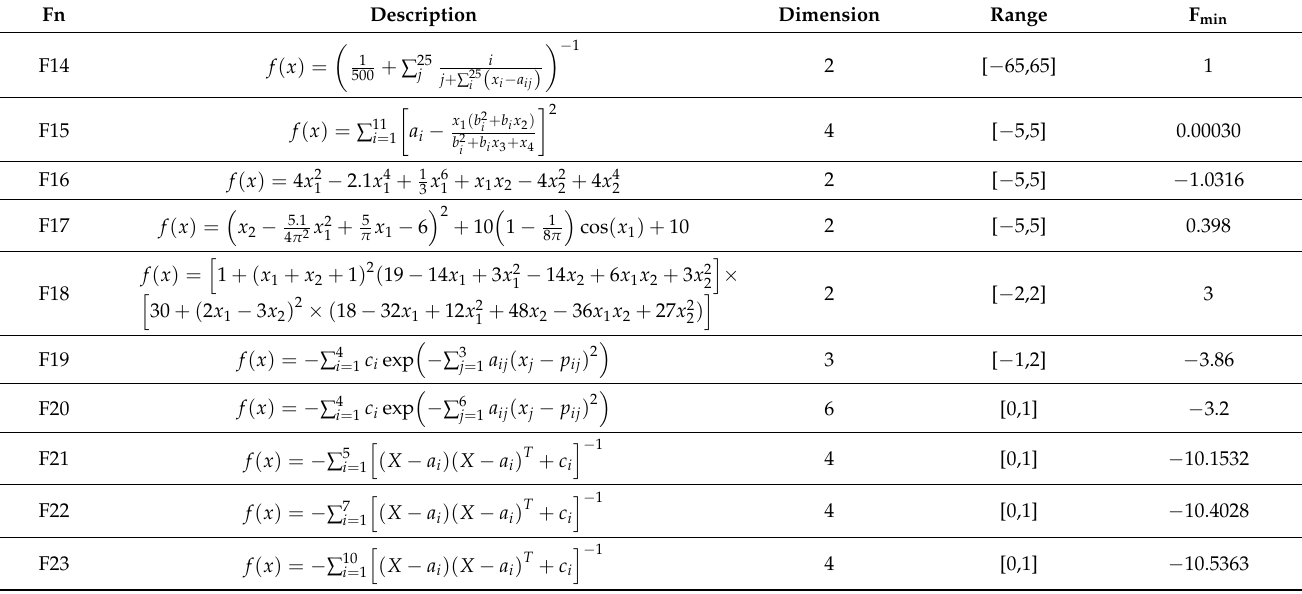
Table 4. Fixed-dimensional multimodal benchmark